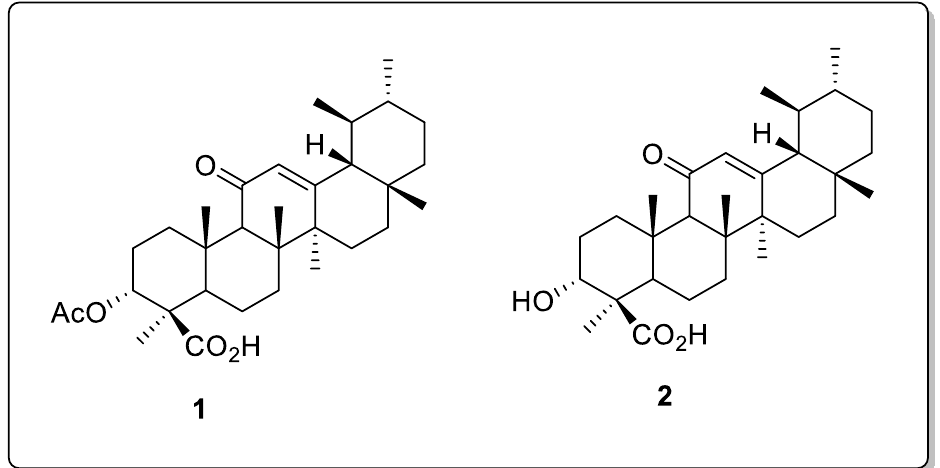
Figure 1. Chemical structures of β -AKBA ( 1 ) and β -KBA ( 2 ).